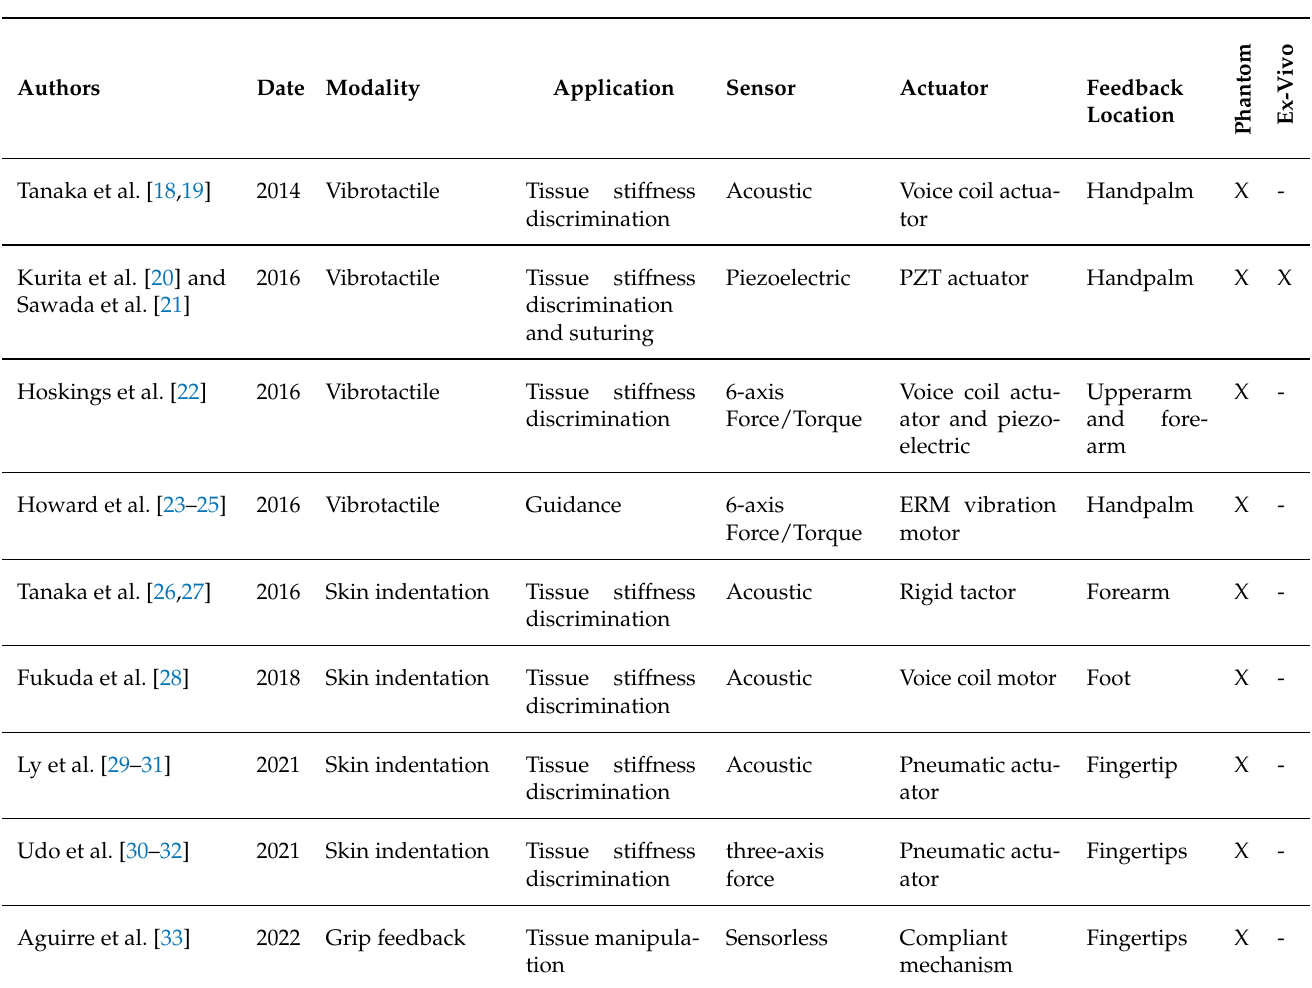
Table 3. Skin tactile